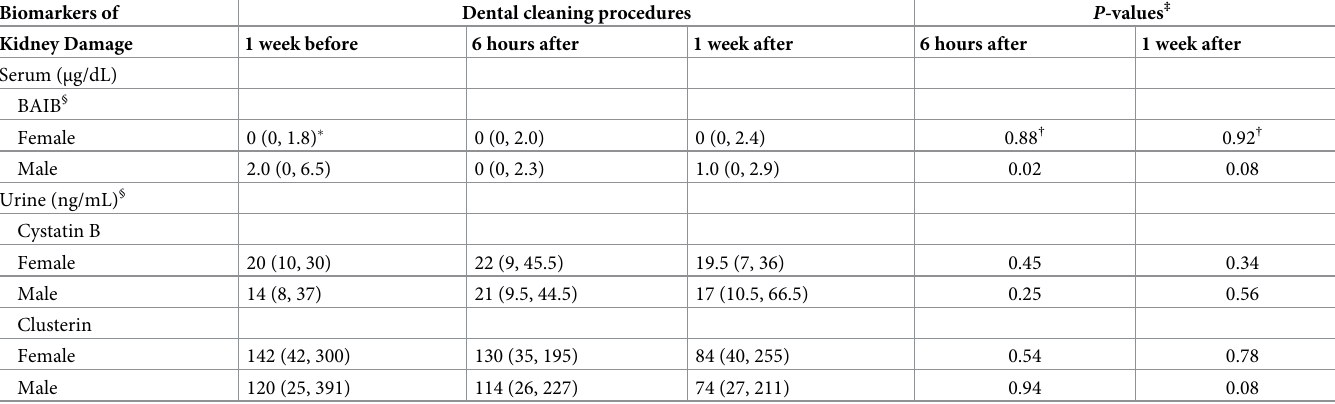
Table 6. Serum and urine kidney tissue damage biomarkers before and after general anesthesia and dental cleaning procedures in cats and dogs with periodontal disease stratified by sex (n = 62) �